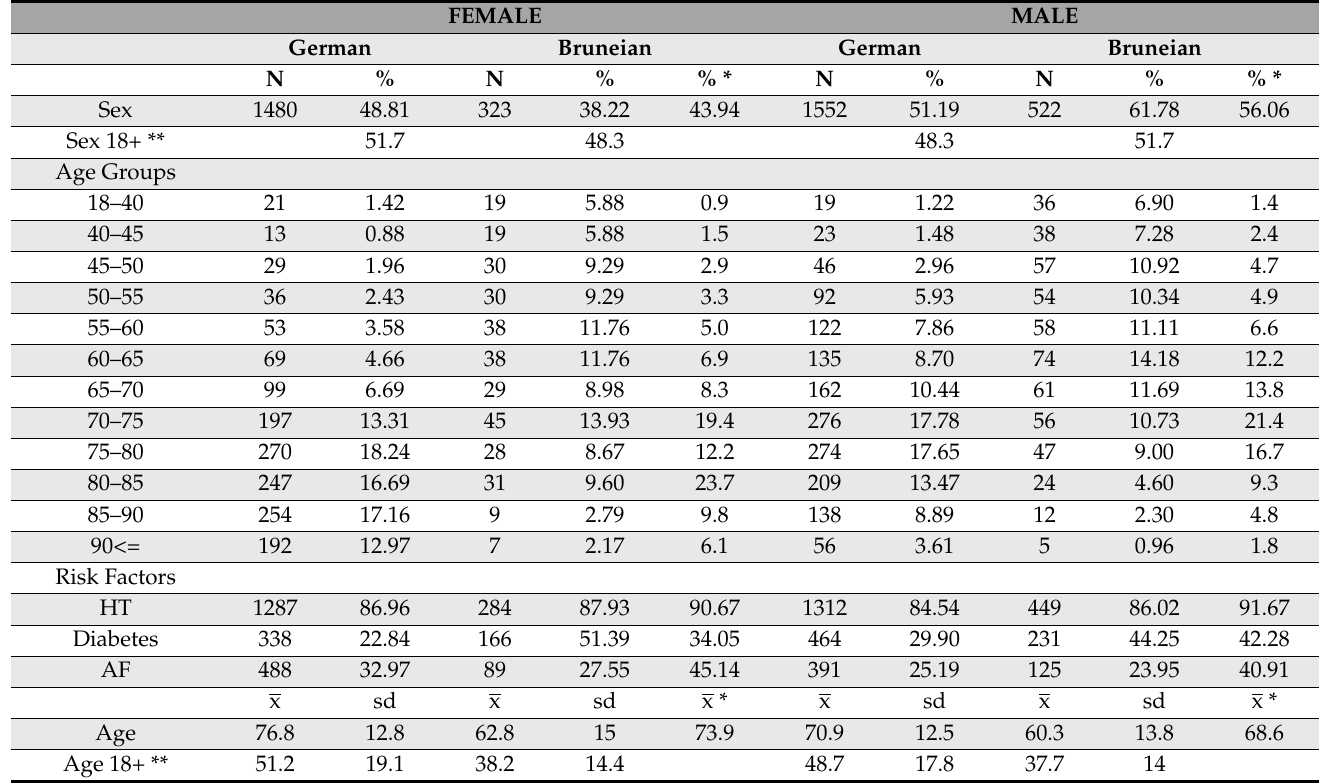
Figure 4. PRR for Atrial Fibrillation by Age group and Sex in Stroke Patients. Table 1. The distribution of demographics and risk factors in German and Bruneian stroke